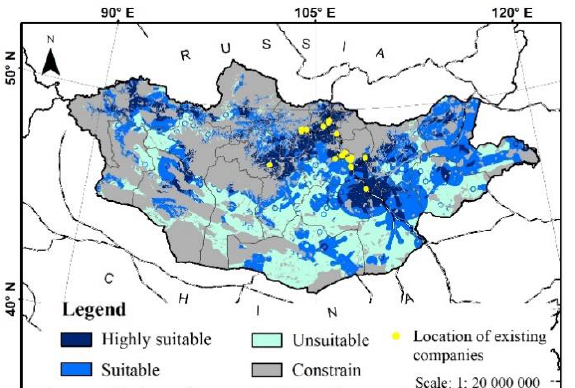
Figure 5. Spatial distribution of validation